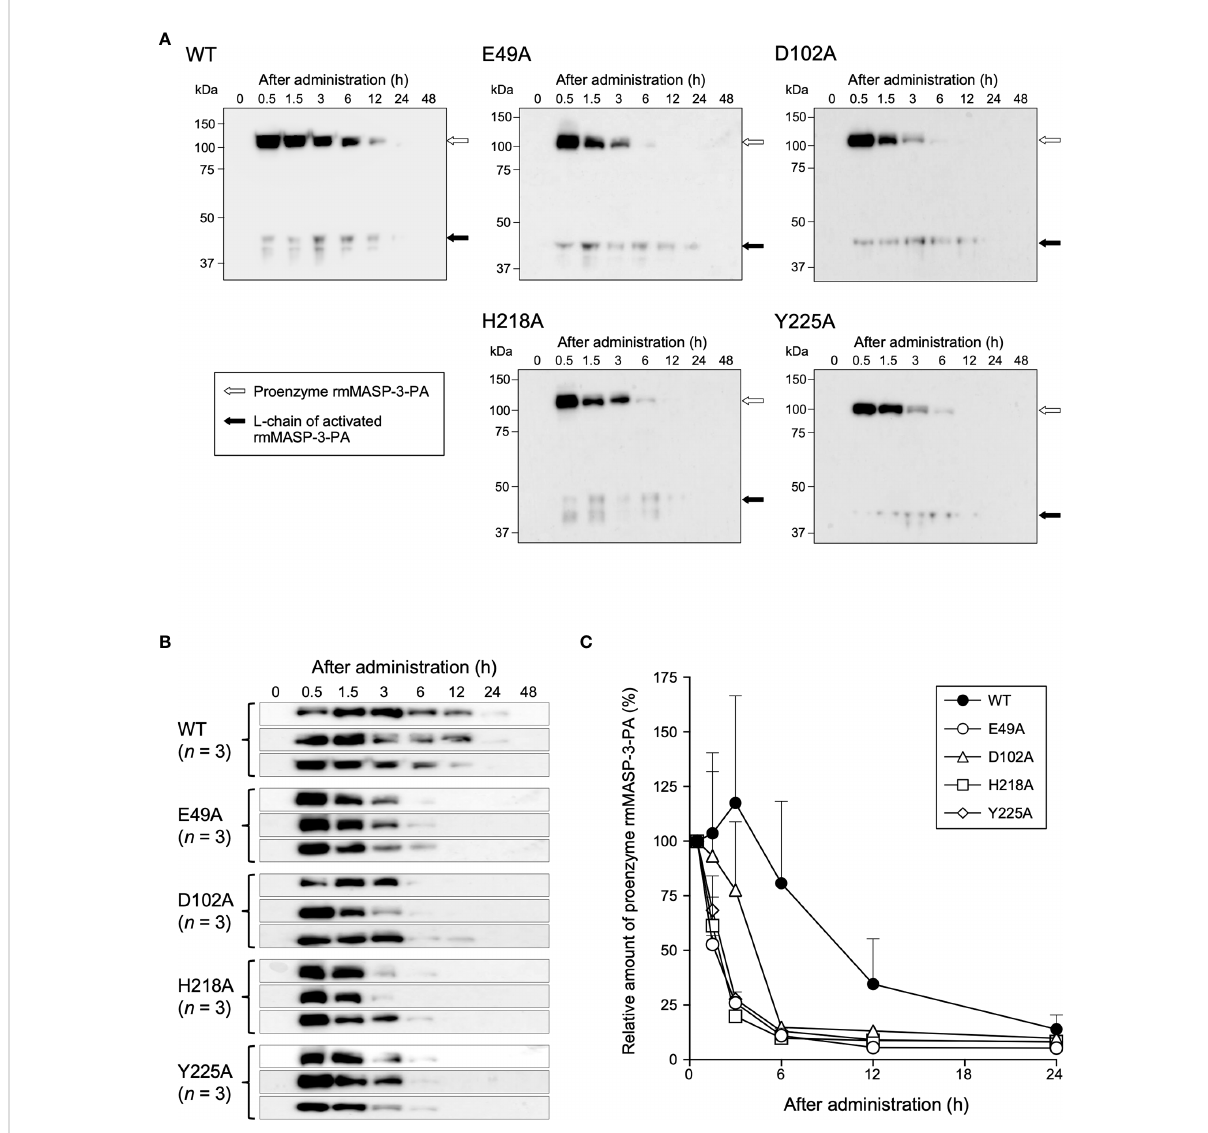
FIGURE 4 In-vivo activation and clearance kinetics of WT and mutant rmMASP-3-PAs when administered to mice. (A) Serum samples obtained at indicated time periods after administrations of rmMASP-3-PAs were subjected to SDS-PAGE under reducing condition followed by Western blotting using anti-PA tag antibody. The white and black arrows indicate bands for proenzyme rmMASP-3-PA and L-chain of activated rmMASP-3-PA, respectively. Similar results were obtained from three independent experiments, and representative images are shown here. (B) In-vivo clearance kinetics of proenzyme rmMASP-3-PAs when administered to mice ( n = 3). (C) Residual amounts of the proenzyme rmMASP-3-PAs in the circulation are represented as the percentage of its band intensity against the intensity in the serum sample obtained 0.5 h after administration from the same